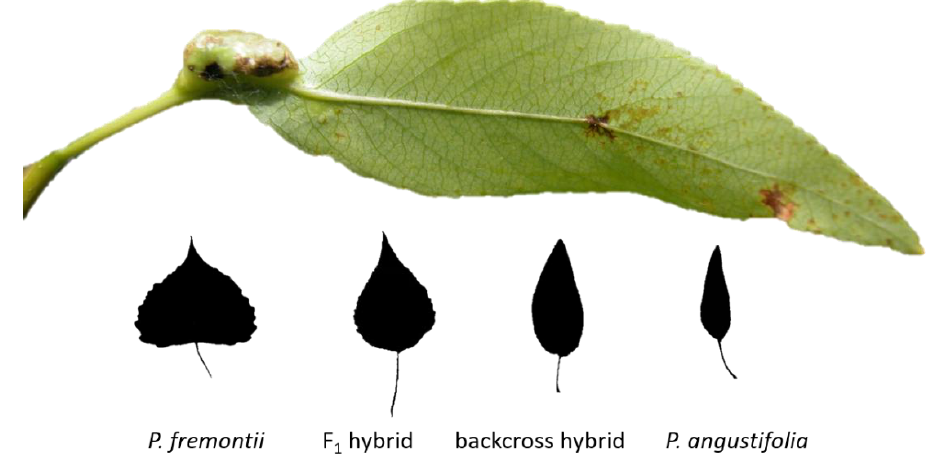
Figure 1. Cottonwood species hybridize between two parents ( Populus fremontii and Populus angustifolia ) to create an F 1 hybrid and a series of backcrosses to the P. angustifolia parent (backcross hybrids). Shown is a Pemphigus betae gall on a narrowleaf cottonwood. Photo by Rick Lindroth, 2005.